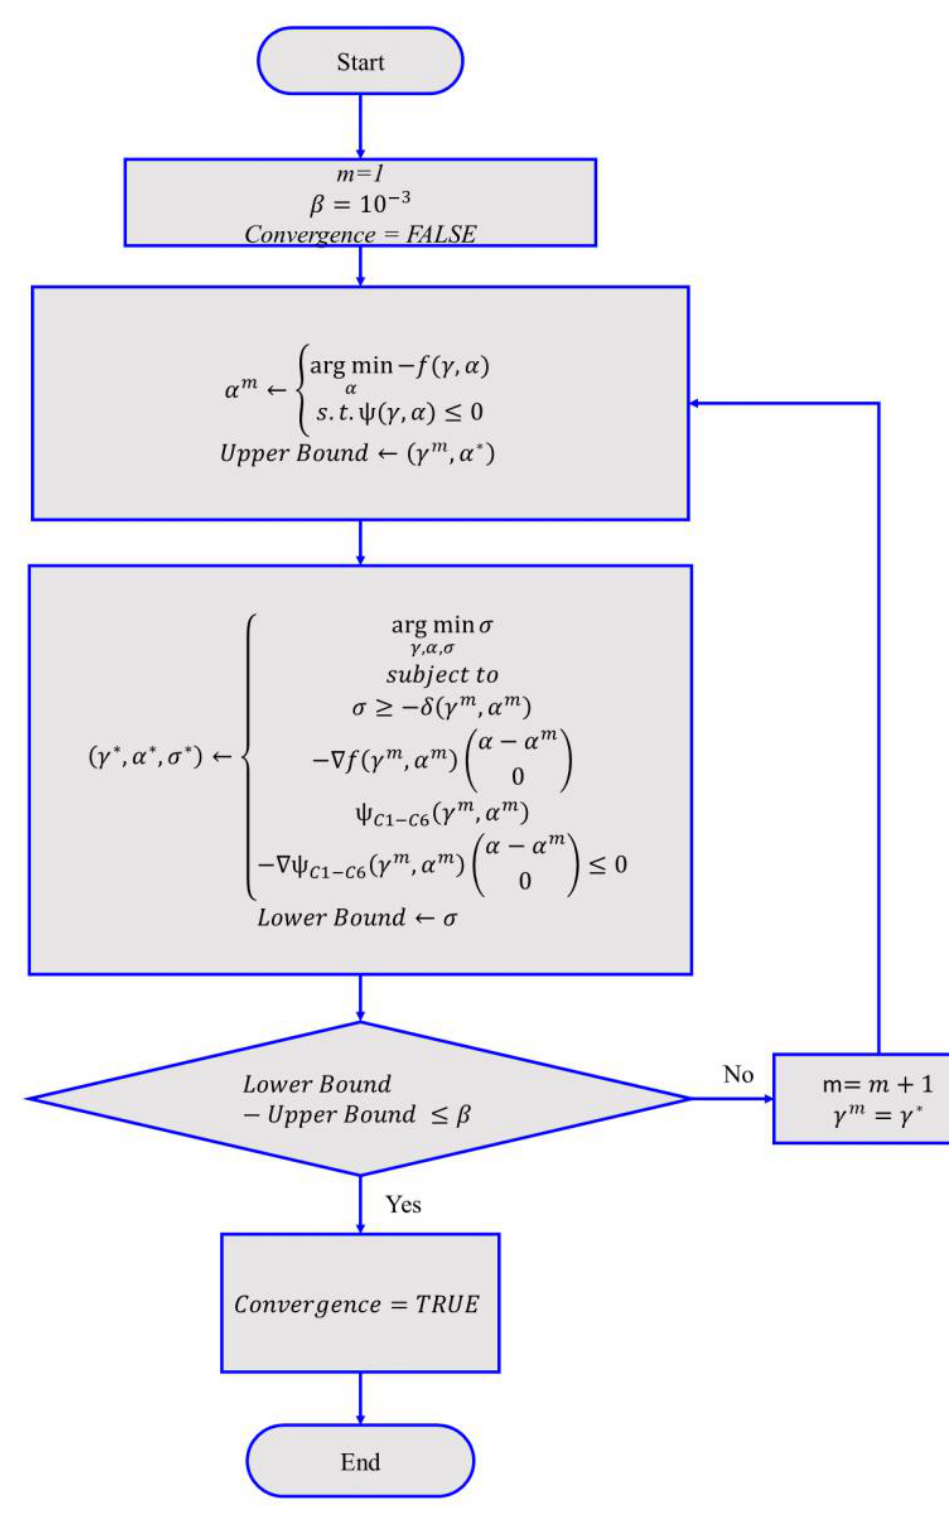
Figure 5. Flowchart of OAA algorithm.